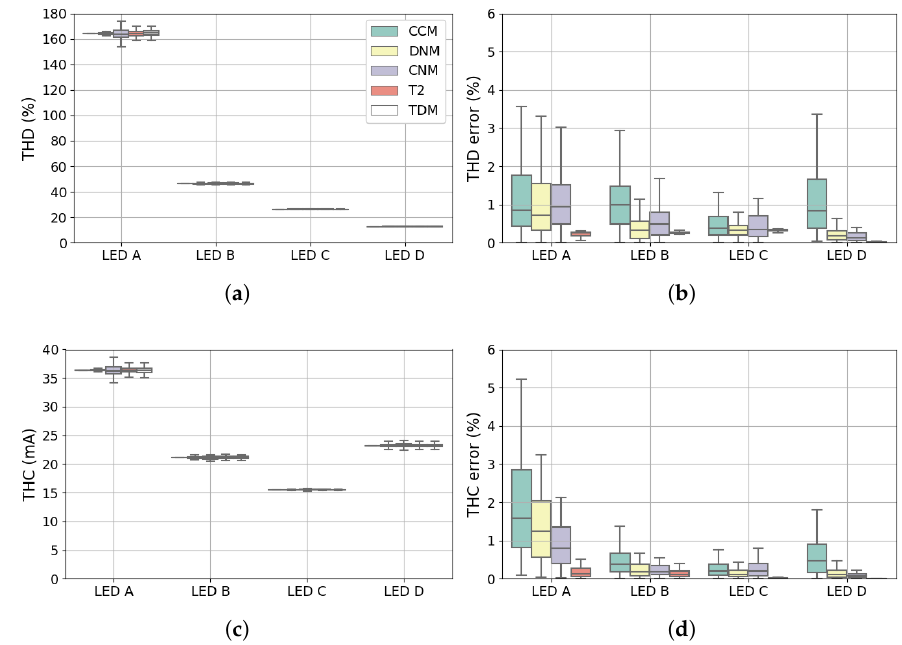
Figure 22. Comparison of the summary indices obtained with different frequency domain models supplied with peak-top voltage: ( a ) THD; ( b ) THD error (relative); ( c ) THC; and ( d ) THC error